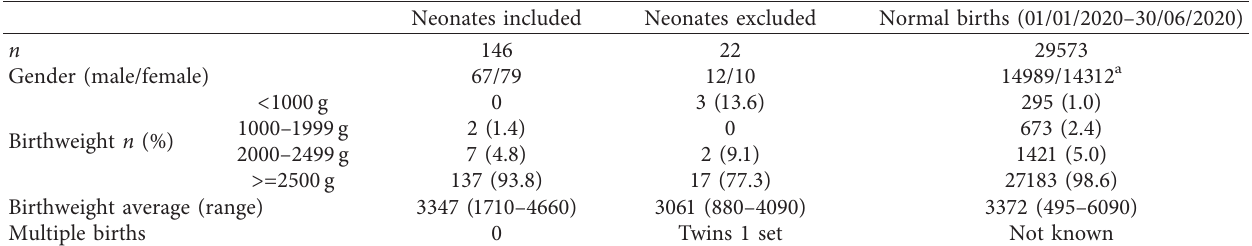
Table 1: Baseline characteristics of newborns conceived following OSCM HSG along with population statistics of normal births in New